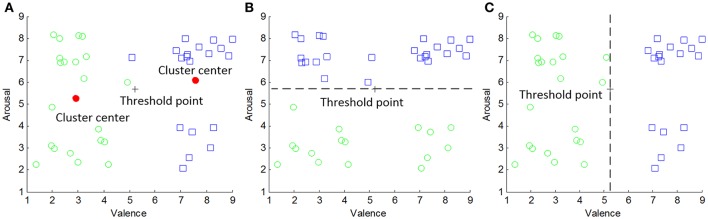
Determination of adaptive thresholds and target emotion classes for subject 1: (A) results of k-means clustering, (B) target classes for arousal dimension, and (C) target classes for valence dimension.